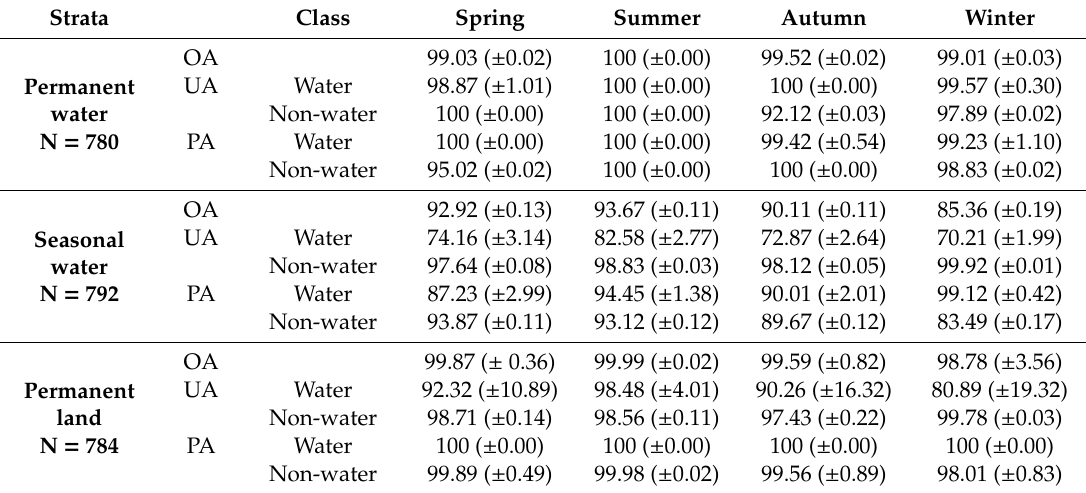
Table 2. Accuracy of instantaneous water detection in seasonal inundation